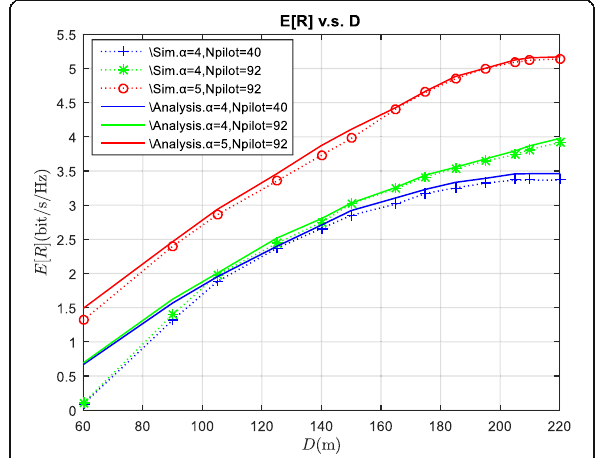
Fig. 8 E [ R ] v.s. D when λ BS = 87/km